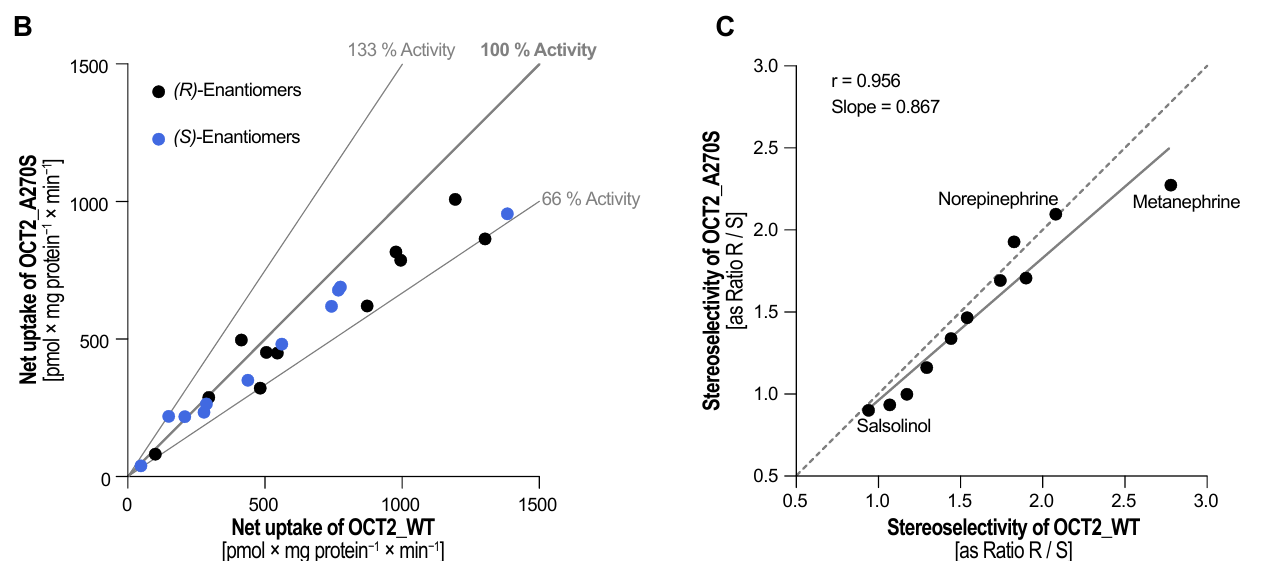
Figure 6. Influence of the A270S polymorphism on the stereoselectivity of monoamine transport by OCT2 ( A ). HEK293 cells stably overexpressing wild-type or mutant OCT2 were incubated with 100 µ M racemic substance for two minutes. Data is shown as mean ± SEM of four independent experiments. Stereoselectivity and selectivity between both transporter variants are summarized in Table S4. Comparison of the net uptake by both transporter variants ( B ). The bisection indicates equal uptake, and the thin grey lines illustrate increased or decreased uptake, respectively. Cor- relation of stereoselectivity expressed as ratio of the uptake of the (R) - to the (S) -enantiomers ( C ). The bisection (dashed line) indicated equal stereoselectivity whereas the solid line illustrated the regression